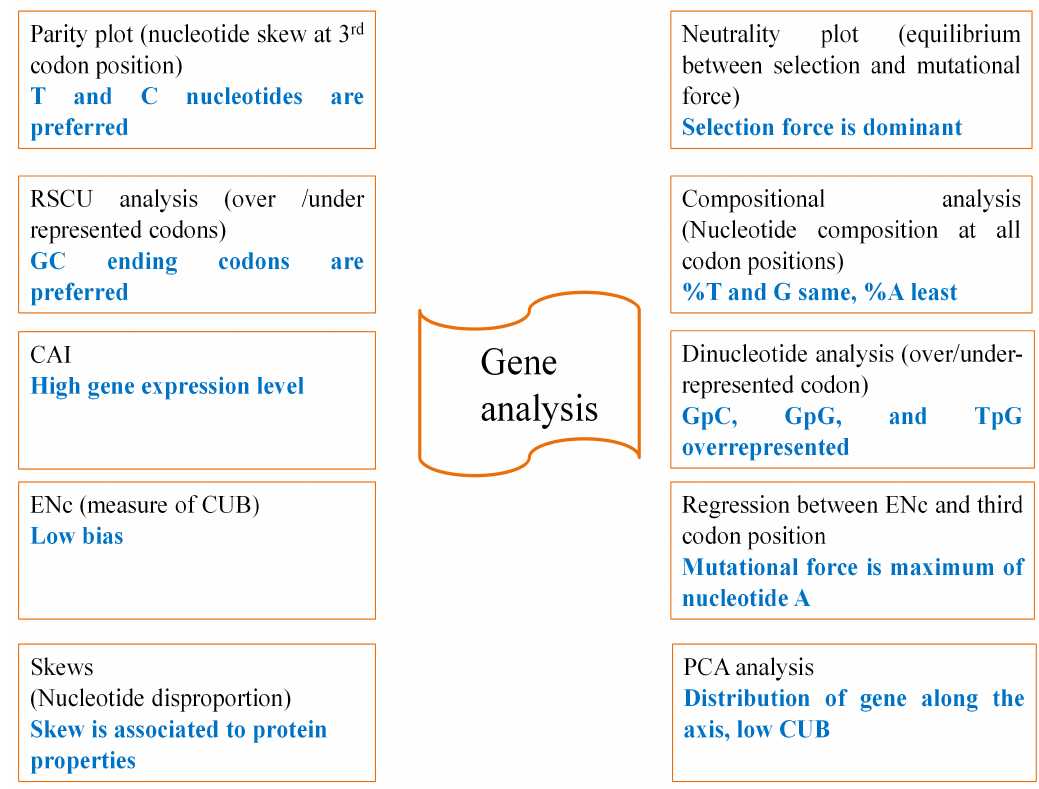
Fig. 10. Diagrammatic presentation of the different methods used and the outcomes. Overall analysis revealed that C ending codons are preferred based on the parity and RSCU analysis. The genes exhibited high gene expression levels with an association of nucleotide skew with protein properties. Overall, genes exhibit a lower bias, which is also affirmed by PCA analysis. The selectional force was dominant in shaping codon usage, and overrepresented dinucleotides were